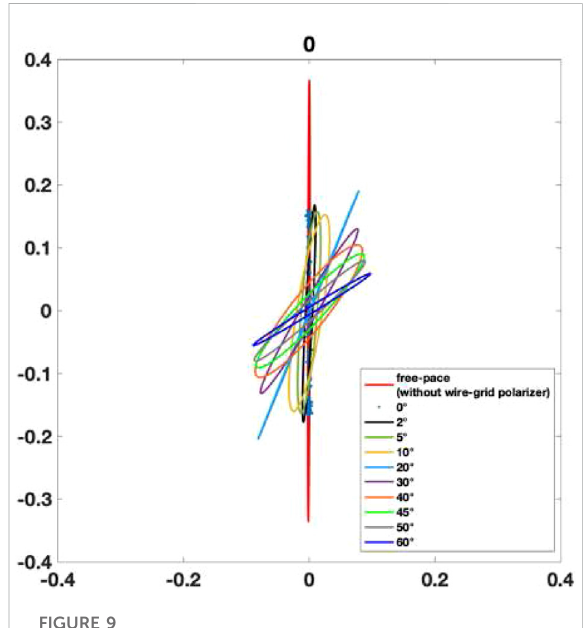
FIGURE 9 Experimental Lissajous fi gures produced from an elliptical fi t of the Lissajous pattern X-Y scope detection at different angular position of the wire-grid polarizer.